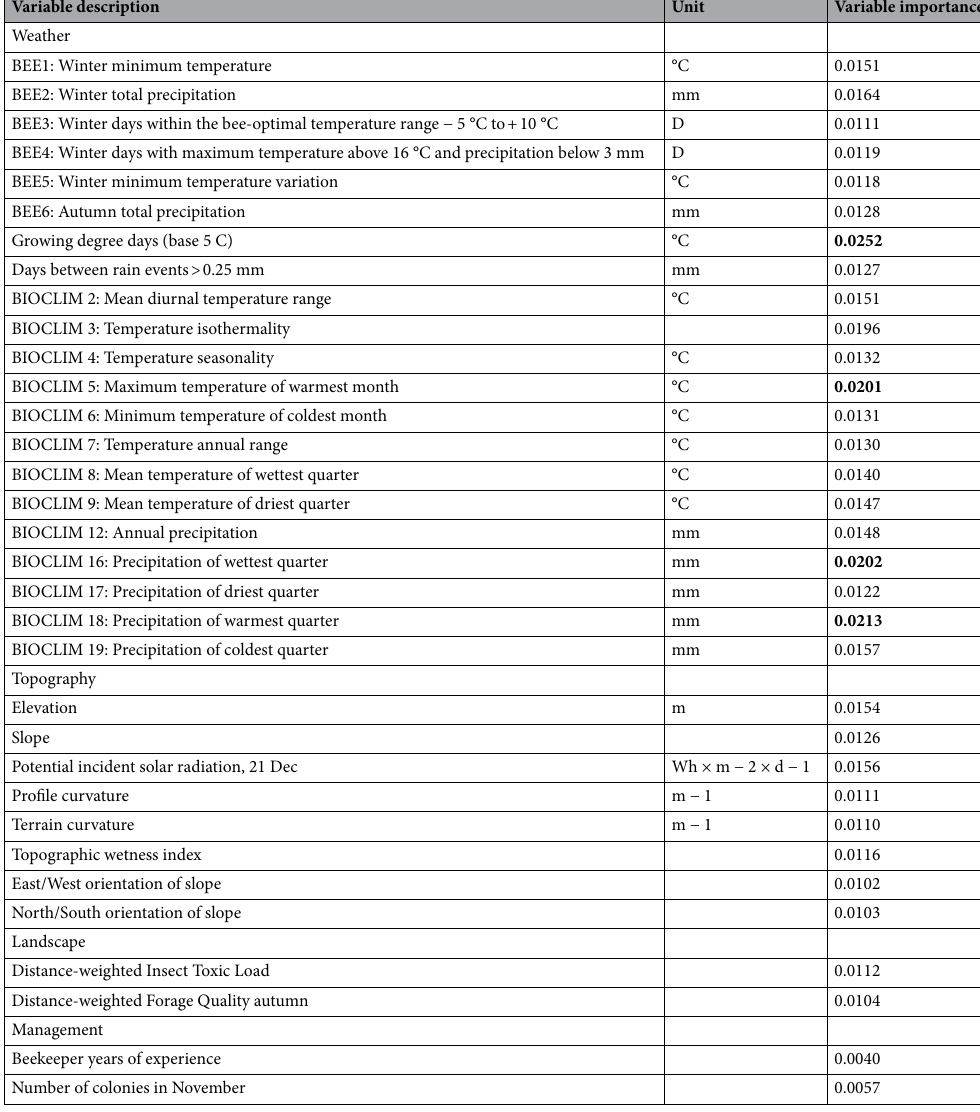
Table 1. Weather and topographic variables hypothesized to affect honey bee overwintering survival. Weather variables include both BIOCLIM 38 and agronomic indices, as well as bee-specific variables developed for this study (BEE#). Permutation variable importance values are from the full colony model; larger values are more influential. The most important four variables are bold. Autumn: September, October, November.